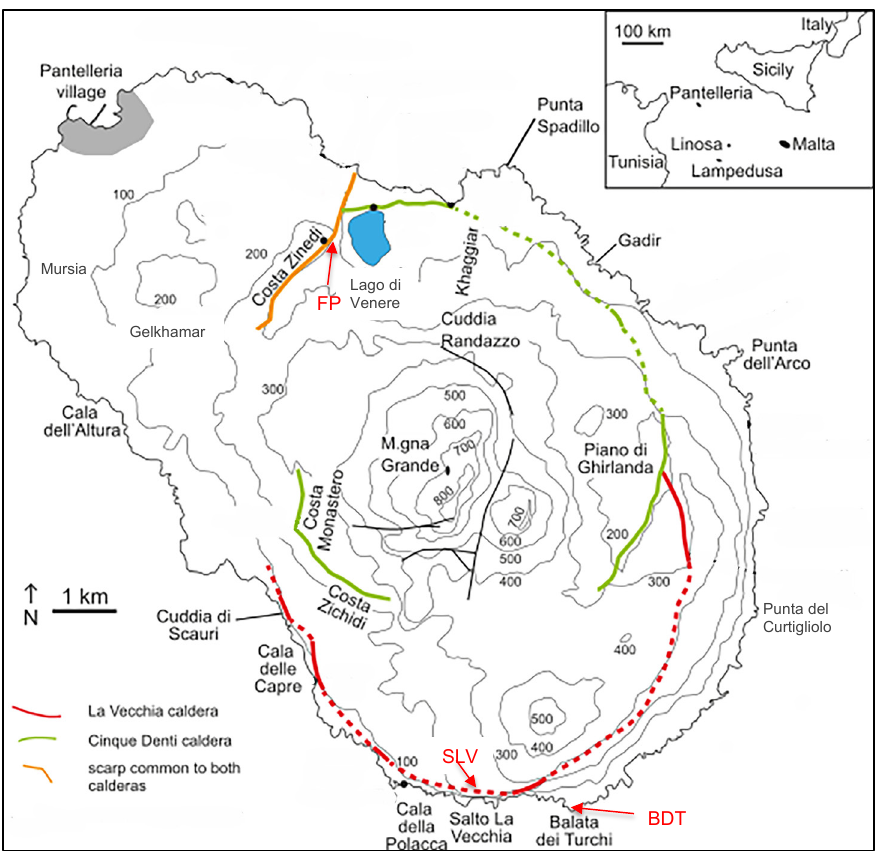
Figure 1: Map of Pantelleria displaying the locations of the four investigated obsidian sites: Fossa della Pernice ( FP ); Salto La Vecchia ( SLV ); Balata dei Turchi ( BDT ). The traces of the two calderas are also shown (modified after Jordan et al., 2018). In the inset the location of Pantel- leria within the Strait of Sicily is